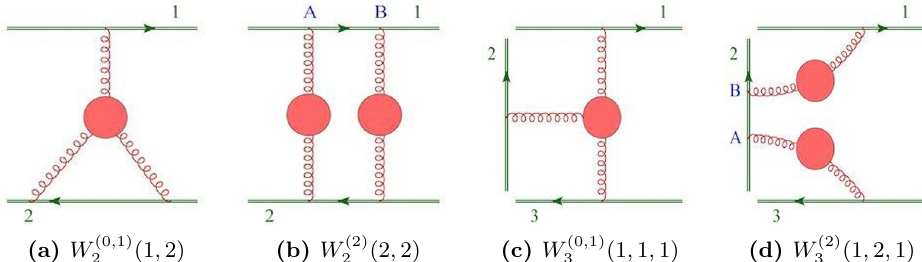
Figure 5. Representative skeleton diagrams for the four non-vanishing Cwebs in a massless theory whose perturbative expansion starts at O ( g 4 ). Cwebs (a) and (c) comprise a single skeleton diagram, while Cwebs (b) and (d) comprise two skeleton diagrams, obtained by permuting the labelled